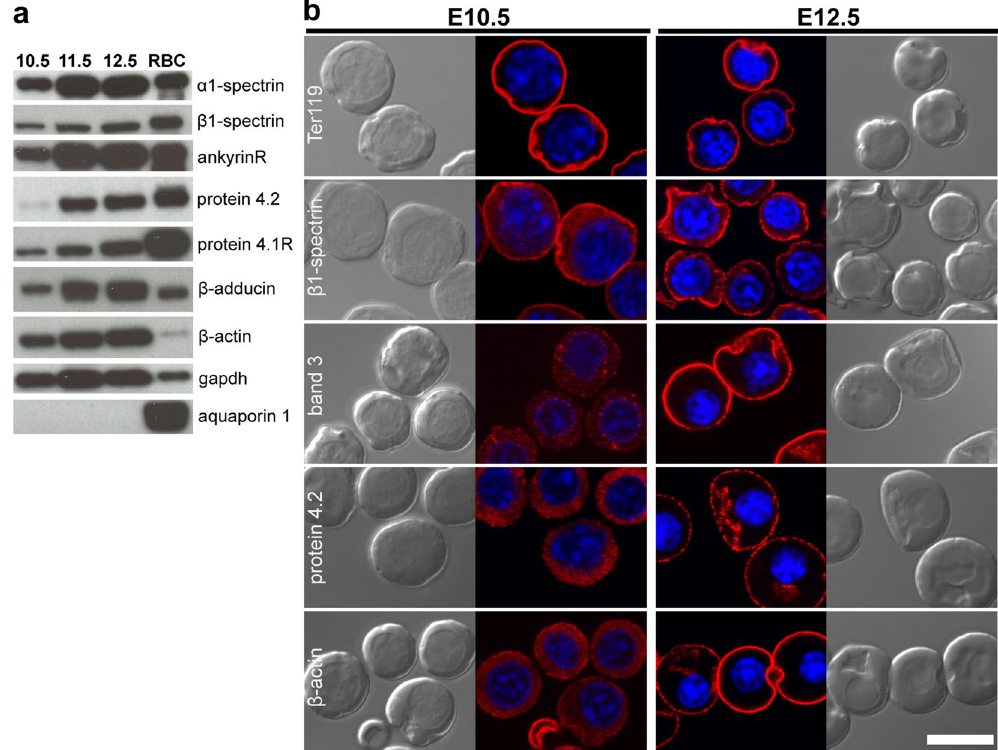
Figure 3. Expression of membrane skeleton proteins in primary primitive erythroblasts. ( a ) Immunoblots of whole cell lysates prepared from 5 × 10 5 cells loaded per lane. RBC, adult RBCs. Representative data from one of two or three independent experiments are shown. ( b ) Immunofluorescence of cytoskeletal proteins (red) in primitive erythroblasts from E10.5 (left panels) and E12.5 (right panels) mouse embryos. Parallel brightfield and fluorescence images are shown. Nuclei were stained with Hoechst (blue). Band 3, protein 4.2, and β -actin become localized to the plasma membrane only at late stages of maturation. Representative data from one of three independent experiments are shown. Scale bar represents 10 µ